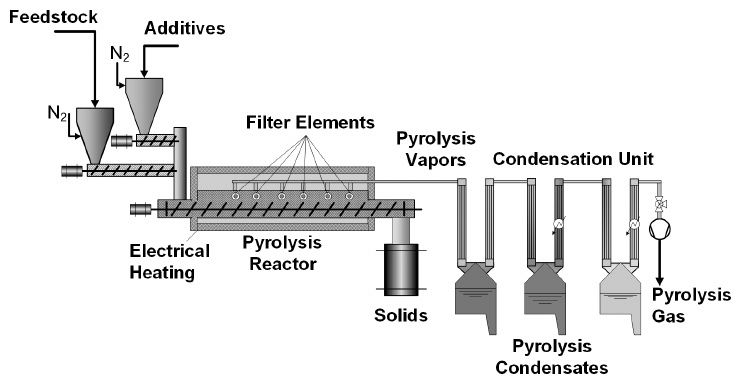
Figure 2. Pyrolysis reactor at the Institute for Technical Chemistry (ITC) at KIT [26].